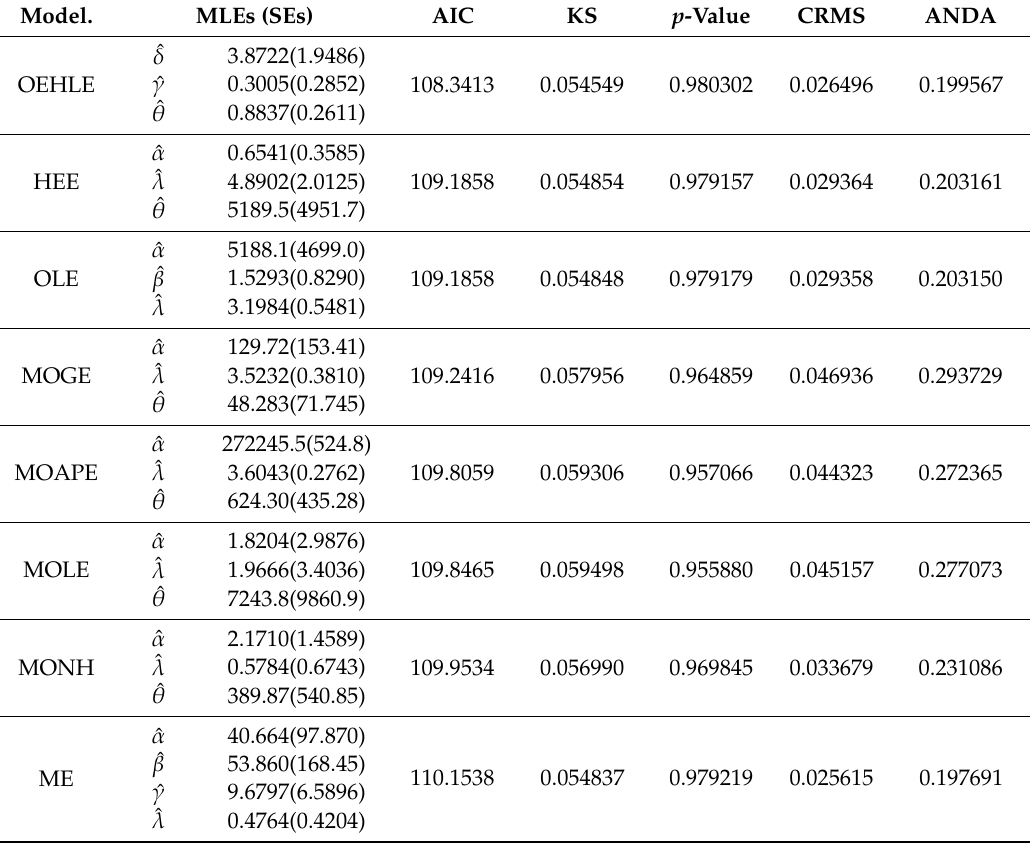
Table3. TheMLEs, associatedstandarderrors(SEs)andgoodness-of-fitmeasuresforgaugelengthsdata.